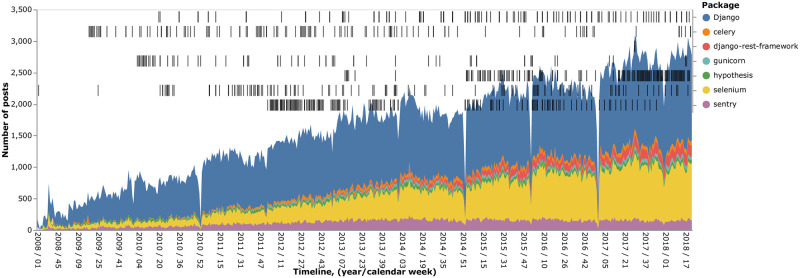
Number of posts and events used in the study.Sample of the posts and the events per package for the available time range. The number of posts is provided in a per-week fashion. The packages are stacked vertically. The spike drops take place in the New Year’s Eve periods.